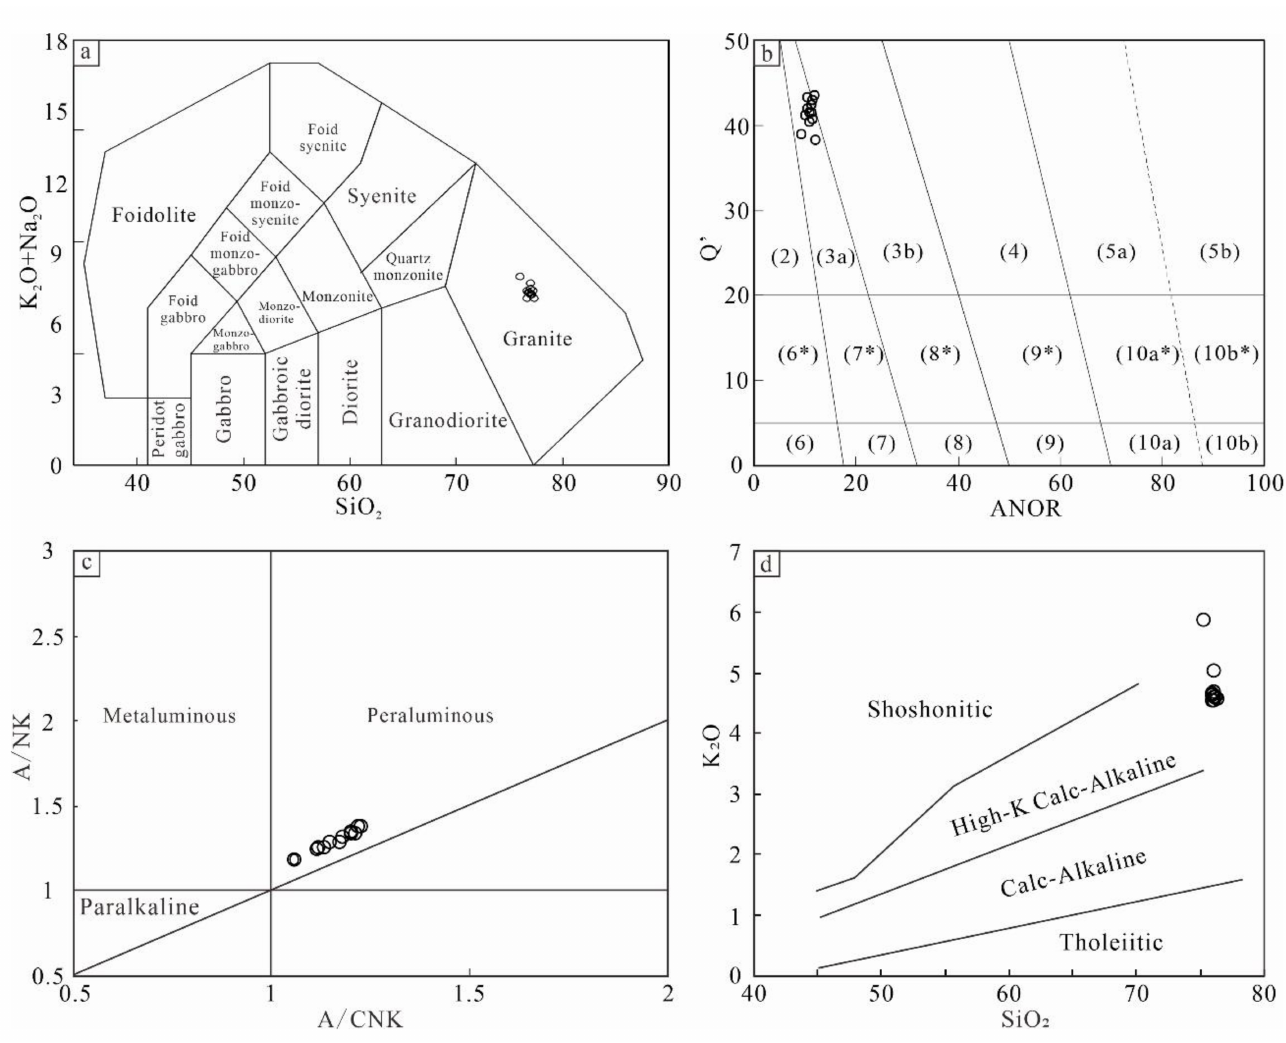
Figure 6. Classification diagrams for LG. ( a )—TAS diagram; ( b )—Diagram of classification of in- trusive rocks (2—alkali feldspar granite; 3a—syenogranite; 3b—monzogranite); ( c )—Diagram of aluminum saturation; ( d )—K 2 O-SiO 2